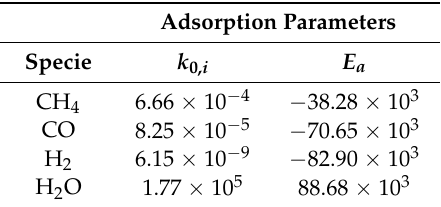
Table A3. Adsorption parameters for reforming